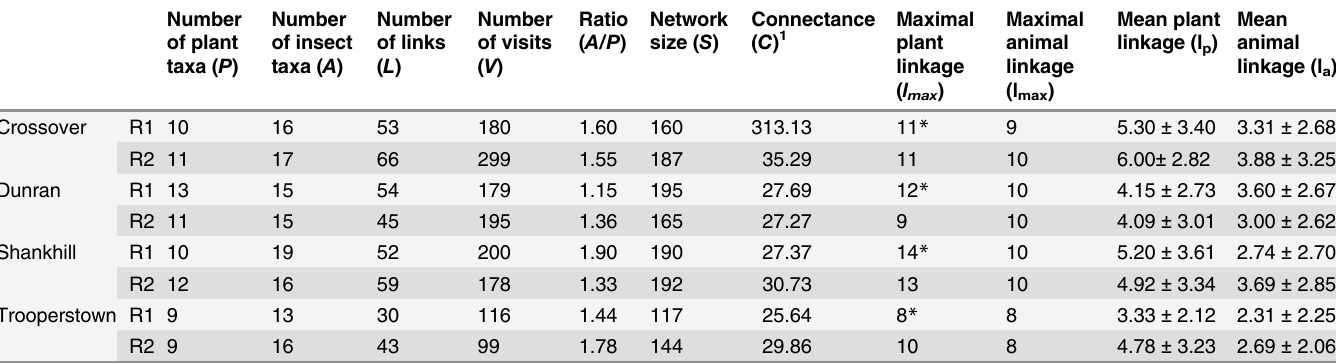
Qualitative network parameters for insect- fl ower interaction networks during (R1) and after (R2) fl owering of invasive Rhododendron ponticum . Qualitative network parameters include the number of plant species ( P ), number of fl ower-visiting insect species ( A ), the total number of unique fl ower-insect interactions (links, L ), the total number of interactions between plants and insects (interactions, I ), ratio of animal to plant species ( A / P ), full network size ( S = A * P ), qualitative connectance ( C = 100 * L / S ) and mean and maximum plant and animal linkage. * indicates that R . ponticum was the plant species with the highest linkage in the